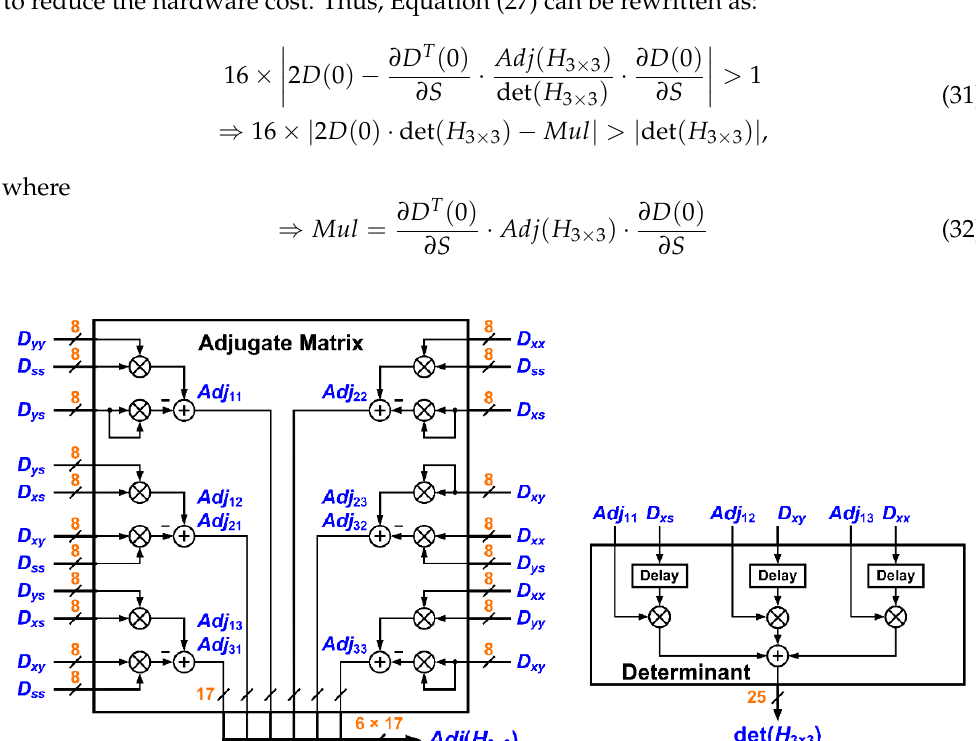
Figure 14. Hardware architecture of the determinant and adjugate matrices.